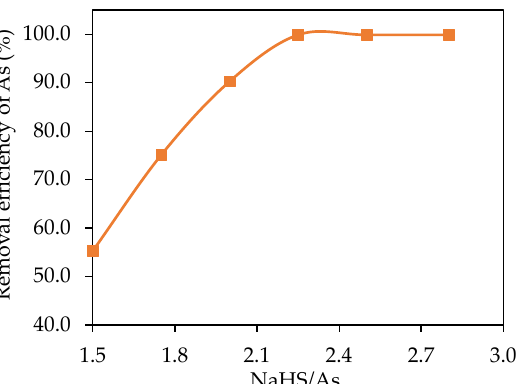
Figure 8. Dependence of the removal efficiency of arsenic (III) sulphide on the NaHS/As molar ratio at 25 ◦ C, pH = 1.5 and As 2 S 3 seed consumption = 34 g/L.